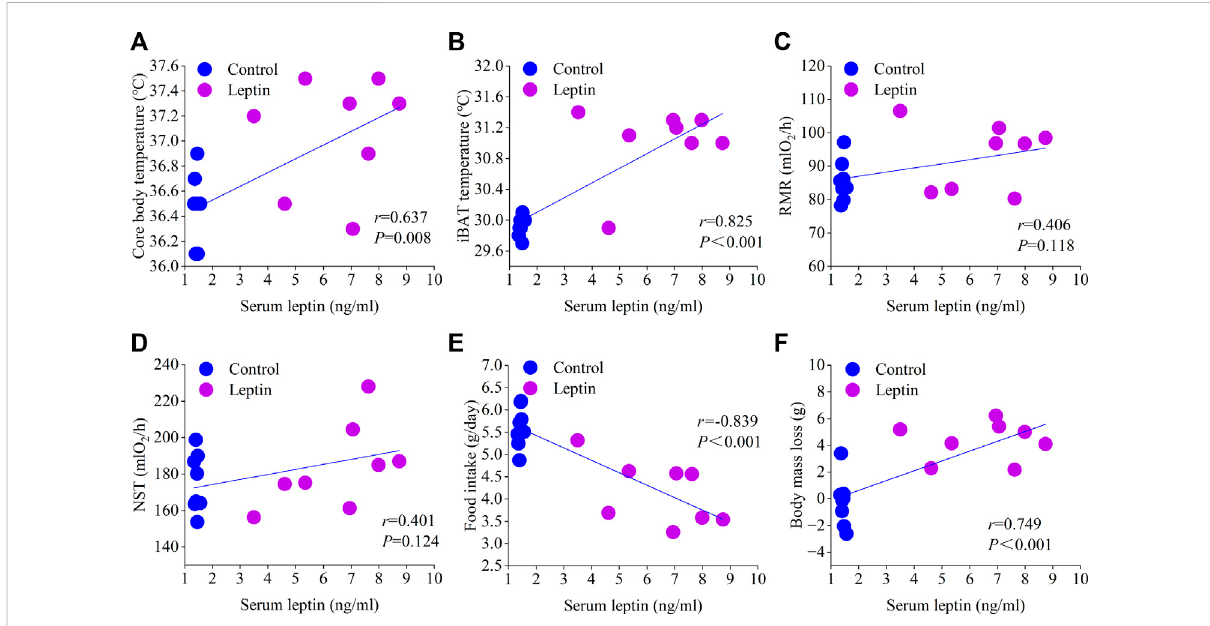
FIGURE 5 Correlation ofserumleptinwith corebodytemperature (A) ,interscapularskintemperature (B) ,RMR (C) ,NST (D) ,foodintake (E) and bodymass loss (F)